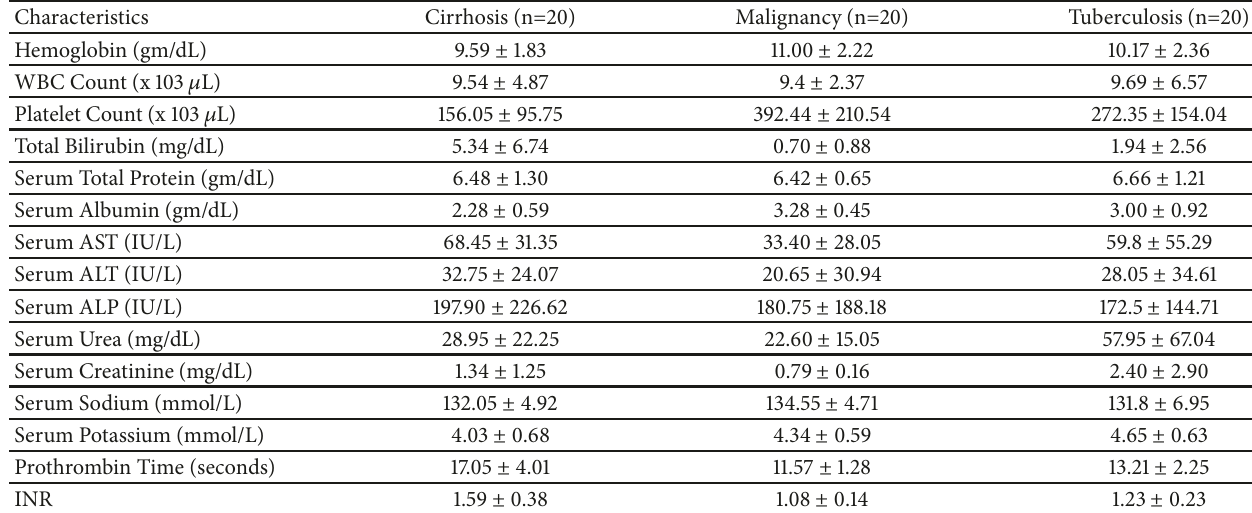
Table 1: Baseline characteristics of patients in three